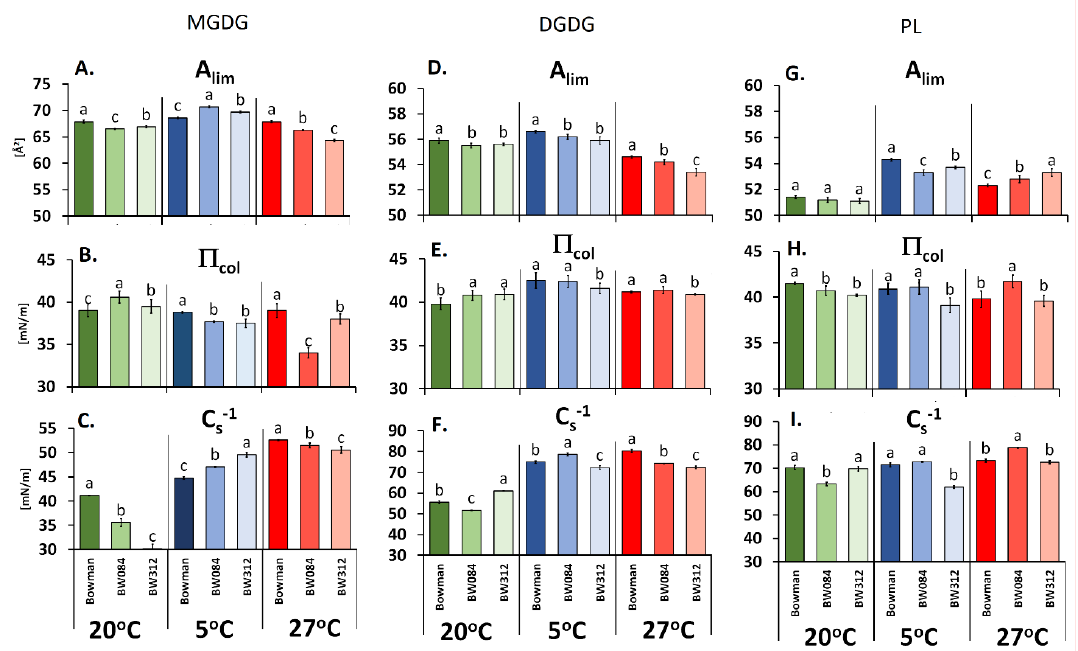
Figure 3. Physicochemical parameters: the limiting area per molecule (A lim [Å 2 ]), collapse pressure (  coll [mN/m]) and compression modulus (C s−1 [mN/m]) of the monolayers that were prepared